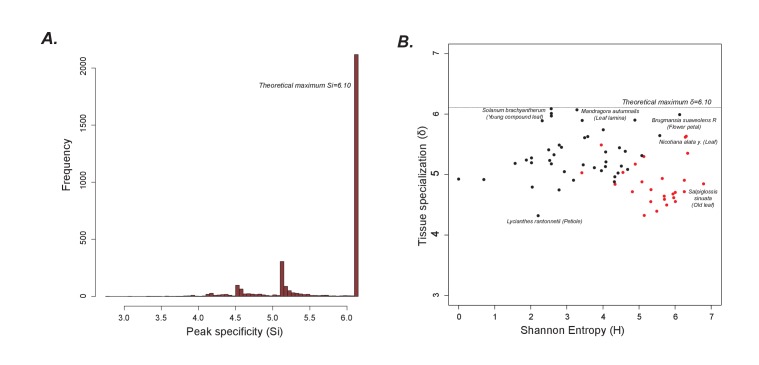
Peak and tissue specialization(A) As shown in Figure 1G, the peaks are largely limited to single samples. Hence, the peak specificity (Si) is at the theoretical maximum. (B) A plot of tissue specialization vs Shannon Entropy shows that in general, tissue specialization is quite high, consistent with the results in Figure 1G. However, acylsugar producing species (red dots) have a slightly lower specialization than non-producers likely because overall, more peaks are shared between acylsugar producing species than non-producers, as can be seen in Figure 1—source data 5.